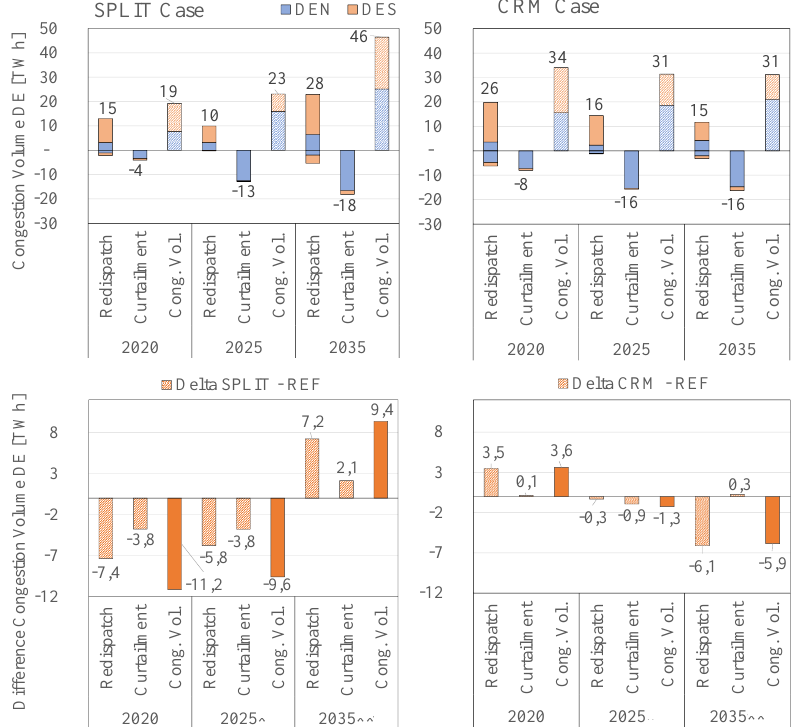
Figure 10. Congestion volumes for Germany and differences in the SPLIT case ( left ) and CRM case ( right ) as compared to the REF